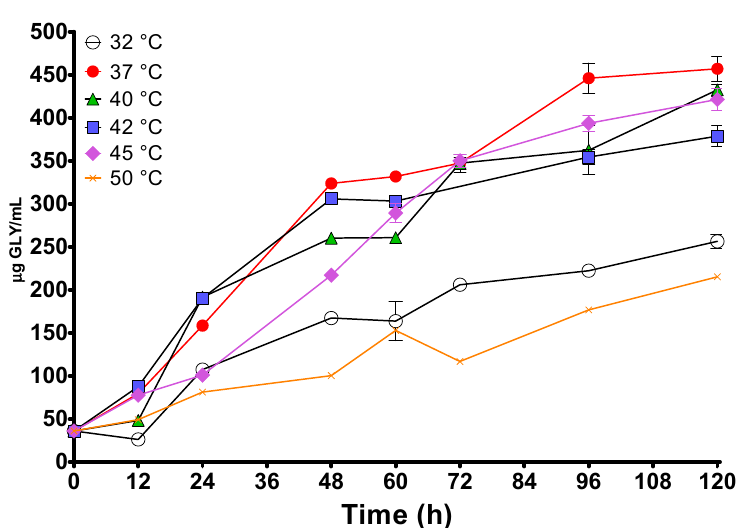
Figure 3. Temperature effect on proteolysis (free α -amino) of whey during fermentation by its native microbiota. Values are expressed as mean ± SD, n = 4.